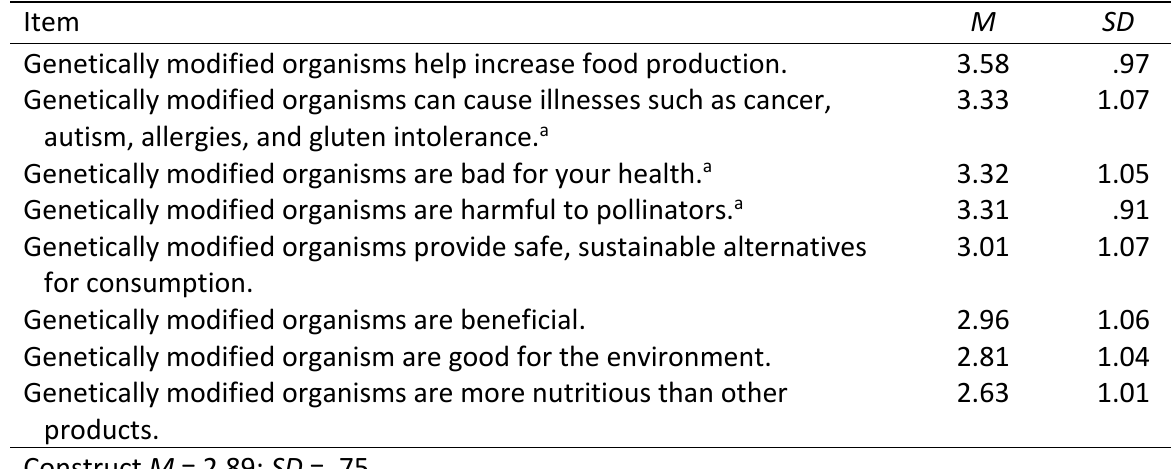
Respondents’ Level of Agreement with Characteristics of GM Products